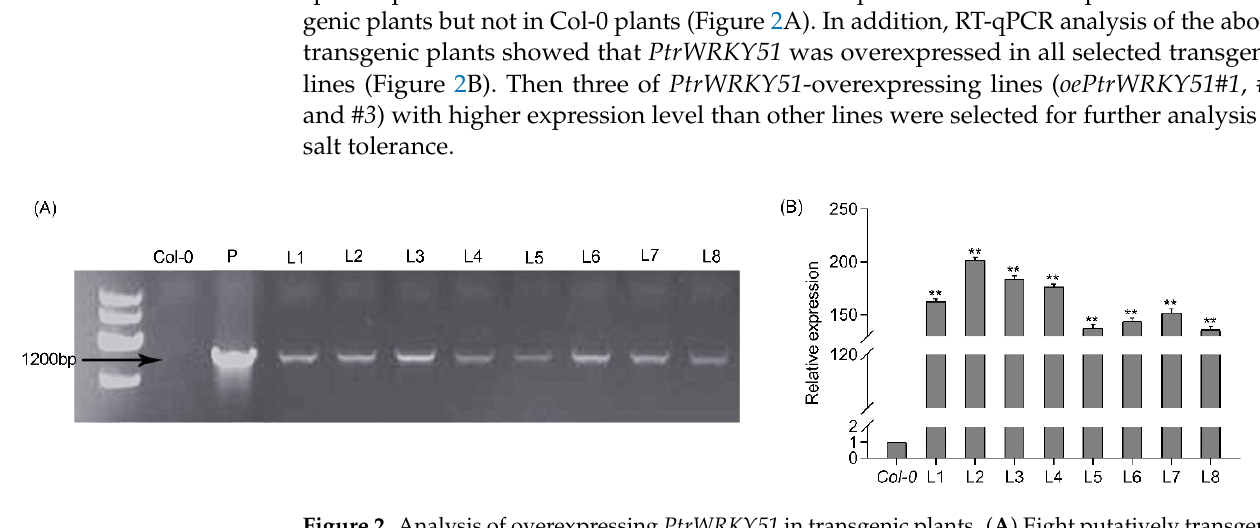
Figure 2. Analysis of overexpressing PtrWRKY51 in transgenic plants. ( A ) Eight putatively transgenic plants of PtrWRKY51 were identified by PCR. ( B ) RT-qPCR was used to detect the transcription level of PtrWRKY51 in different lines. The data are represented as means ± SE ( n = 6). The asterisks (**) represent a significant differences (** p < 0.01) compared to the control.